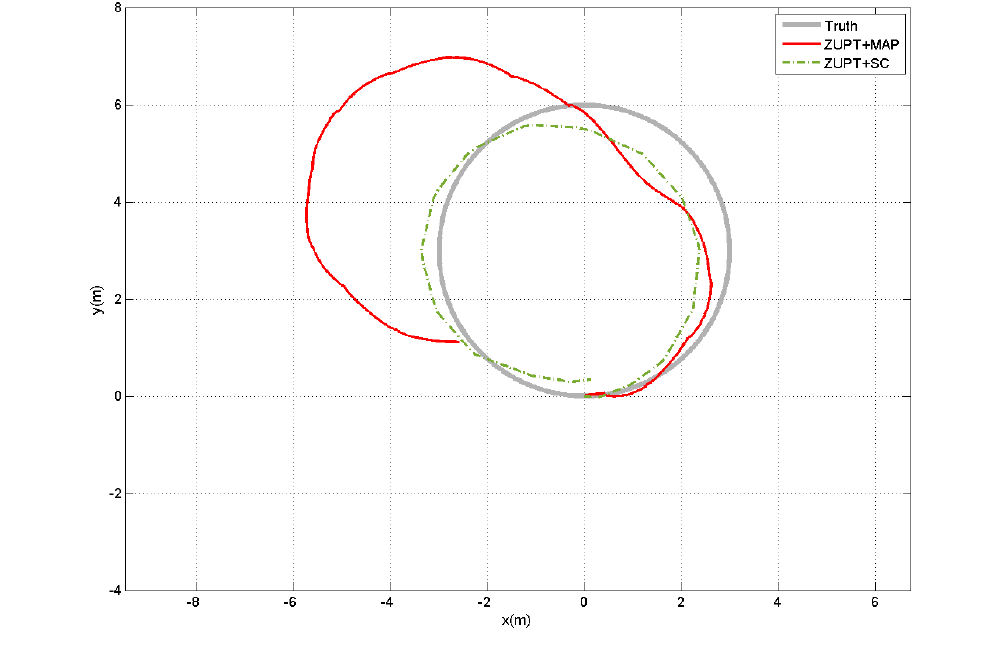
Figure 9. Examples of the estimated position results for walking in a circle with radius of 3 m, where no map information was